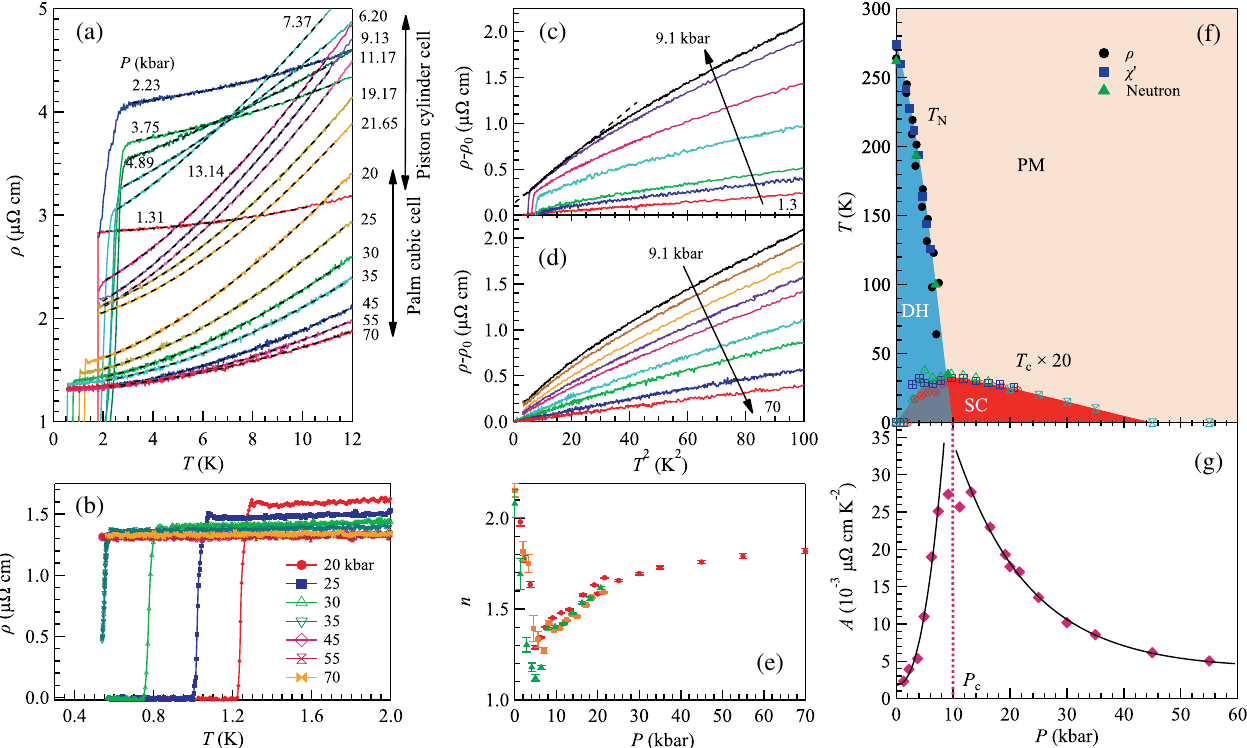
FIG. 5. (a) Temperature dependence of the resistivity ρ ð T Þ for CrAs single crystal under various pressures up to 70 kbar measured in a piston cylinder cell and a palm cubic anvil cell, as indicated in the figure. The ρ ð T Þ data were fitted with the power law ρ ð T Þ ¼ ρ þ BT n , and the fitting curves are shown as the broken lines. The obtained exponent n as a function of pressure is given in (e). 0 The square and triangle symbols represent the results from the other two samples. The ρ ð T Þ data below 2 K in the pressure range 20 – 70 kbar are shown in (b) to illustrate the gradual suppression of T to below 0.5 K. (c),(d) Plots of ( ρ - ρ 0 ) vs T 2 for CrAs under c various pressures highlighting the evolution of the quadratic coefficient A and deviation from Fermi-liquid behavior. A linear fitting was applied in the low-temperature region to extract the coefficient A , which is displayed in (g). (f) An updated T - P phase diagram of CrAs showing the complete suppression of T around 45 kbar. DH denotes double helical order, SC stands for superconductivity, and PM c ≈ 10 kbar in stands for paramagnetism. The coefficient A for CrAs displays an apparent enhancement around P c